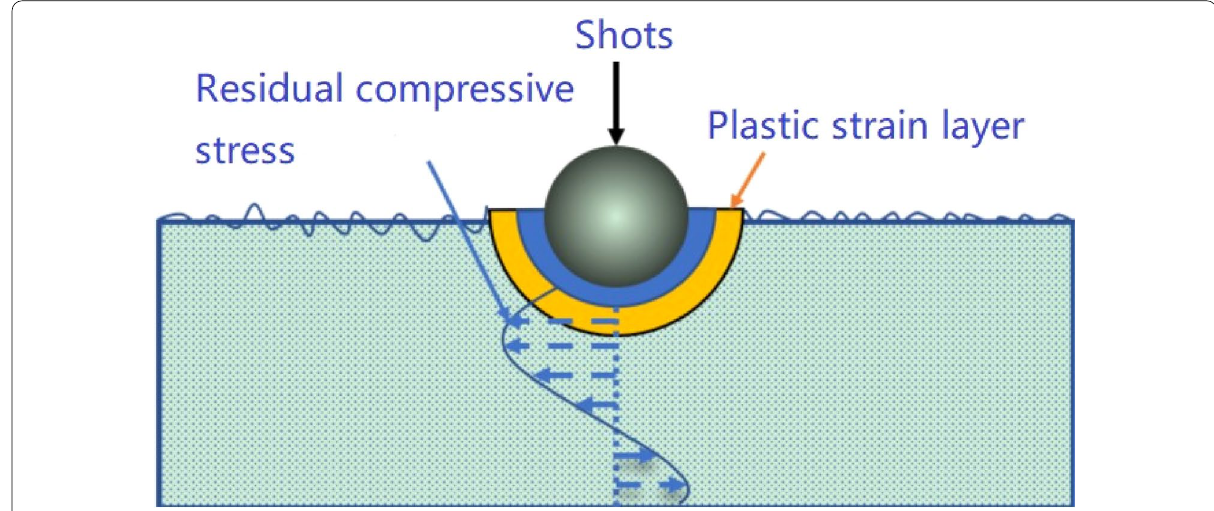
Figure 2 Schematics of SP strengthening process